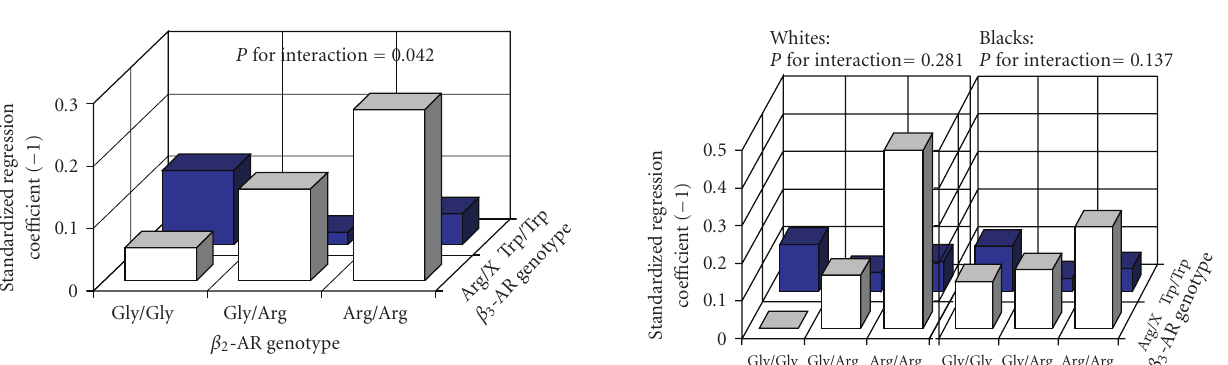
Figure 2: Relationship between Age-related Trend of Systolic Blood Pressure and Birth Weight by β 2 -AR Arg16Gly and β 3 -AR Trp64Arg Genotypes: The Bogalusa Heart Study Arg/x stands for Arg/Trp and Arg/Arg genotypes combined.